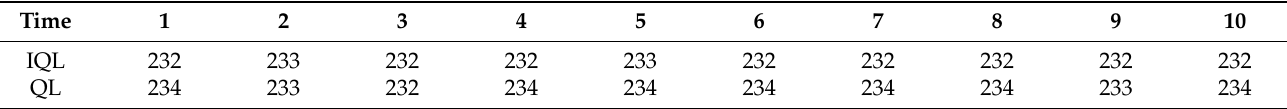
Table 2. Comparison of IQL and QL.